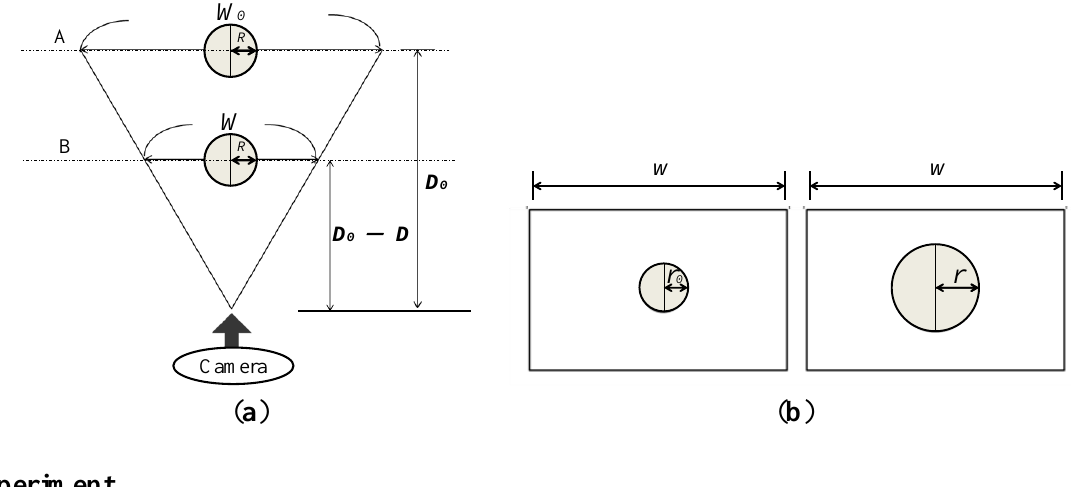
Figure 8. ( a ) Size of object area depends on its location. The object area at location B is larger than that at location A in the image captured by the camera. ( b ) Image captured by the camera when object is located at A (left) and object is located at B